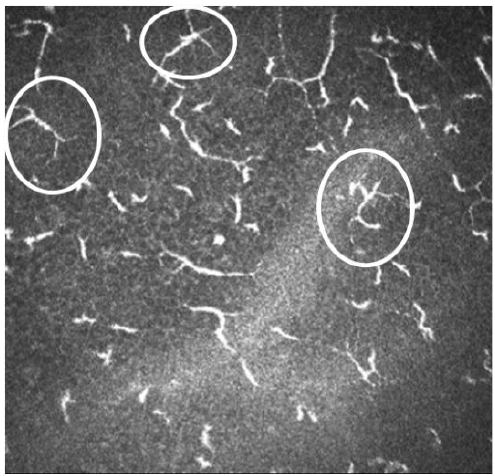
Figure 7. Image of IVCM of dendritic cells. In white circles are shown some of the active